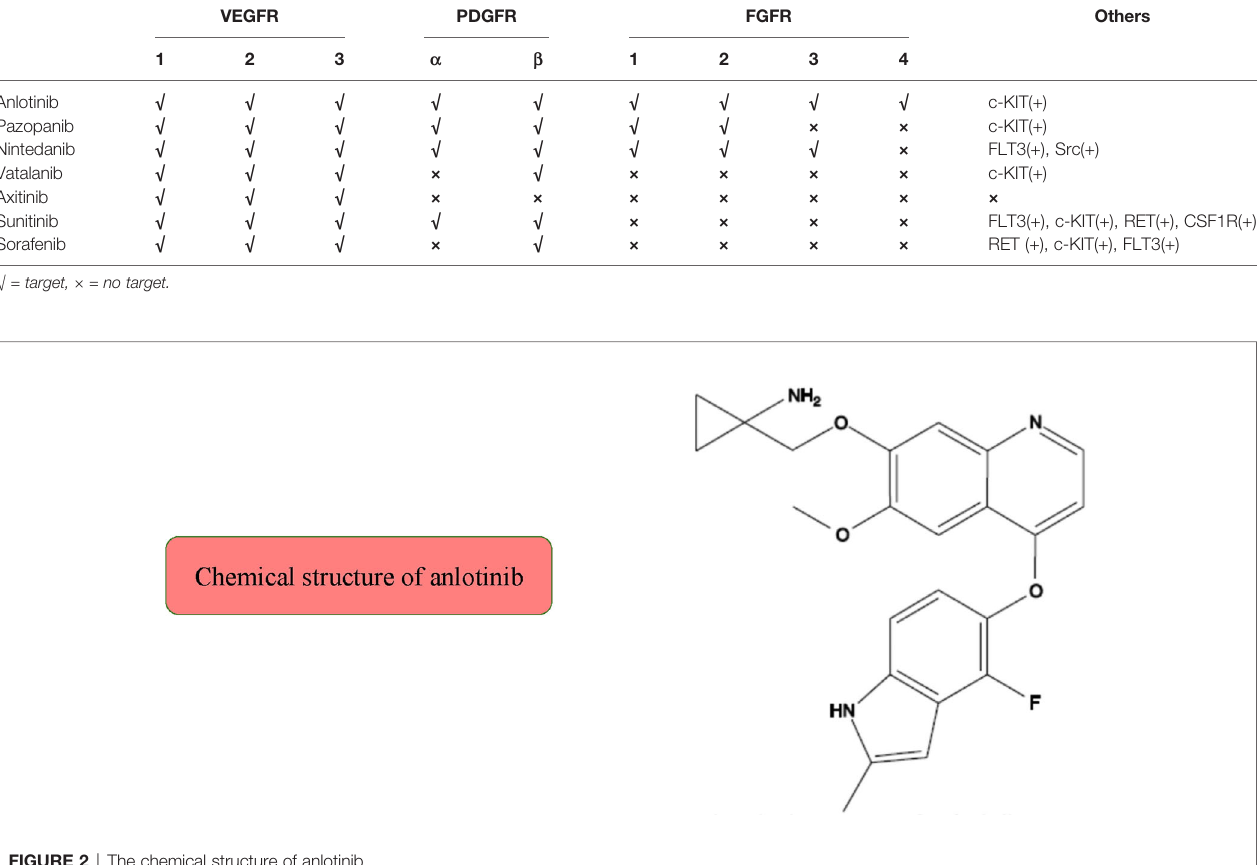
FIGURE 2 | The chemical structure of